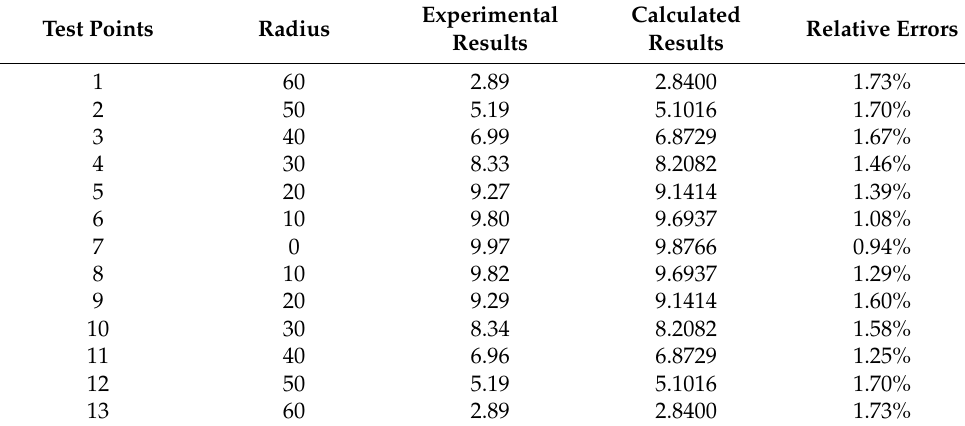
Relative errors = |Experimental results–Theoretical results|/Experimental results.